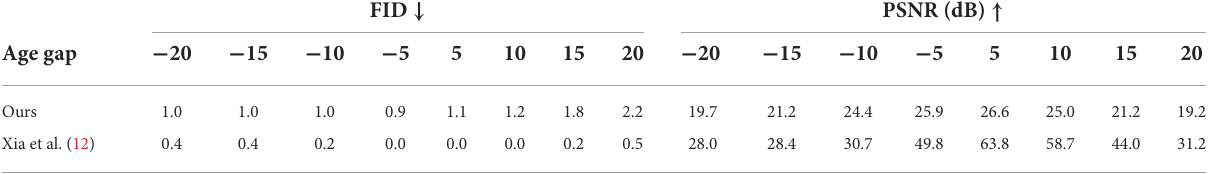
TABLE 2 Image quality in terms of Fréchet inception distance (FID) and peak signal-to-noise ratio (PSNR) for images generated synthetically from a random testing set of 907 subjects with varied age and grouped in age gaps of 5 years.